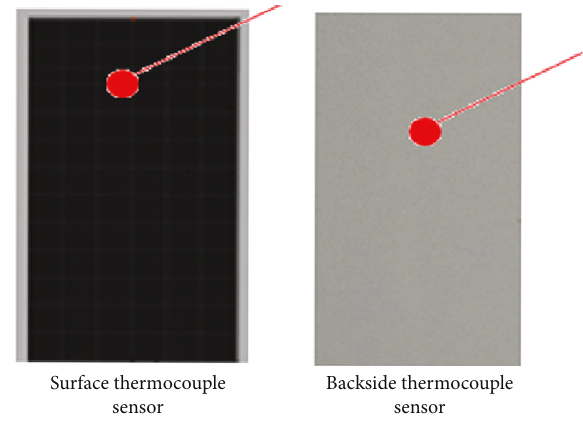
Figure 3: Pasted thermocouple sensors on the surface and backside of each photovoltaic experimental setup. The data of each PV module was Table 2. The photovoltaic modules were fi xed on an iron recorded for a whole year from November, 2015, to October, structure, facing true south at an inclination of 12 ° to the hor- 2016, for the development of a suitable model for the izontal plane. Figure 2 shows the schematic diagram and